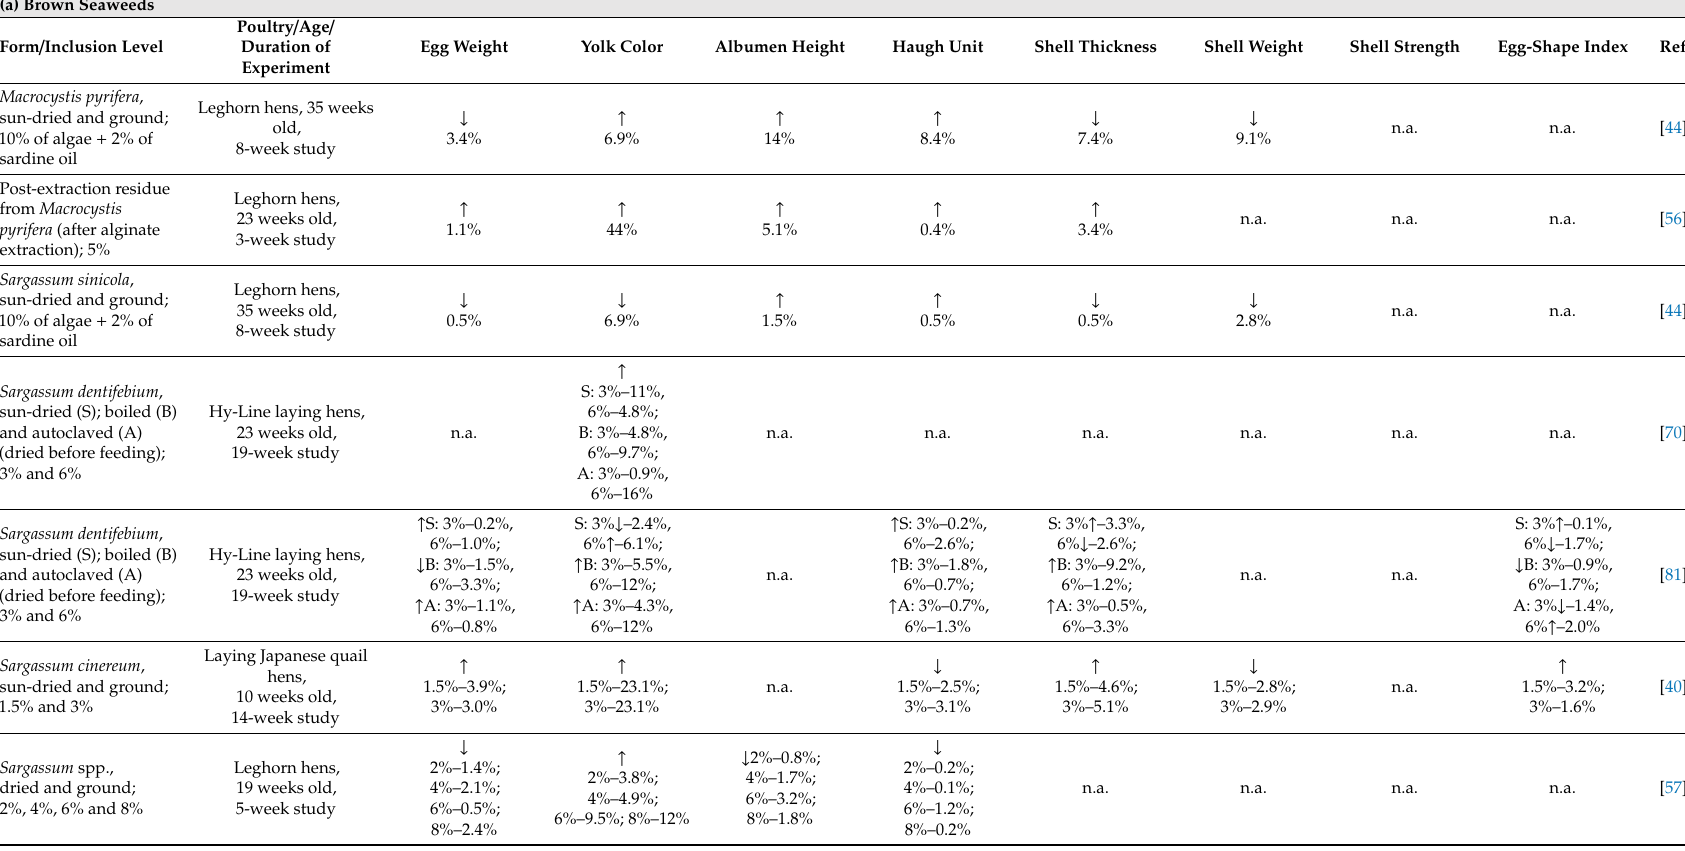
Table 1. Examples of egg quality parameters of poultry feed with seaweeds. (a) Brown; (b) green: (c) red (in comparison with the control